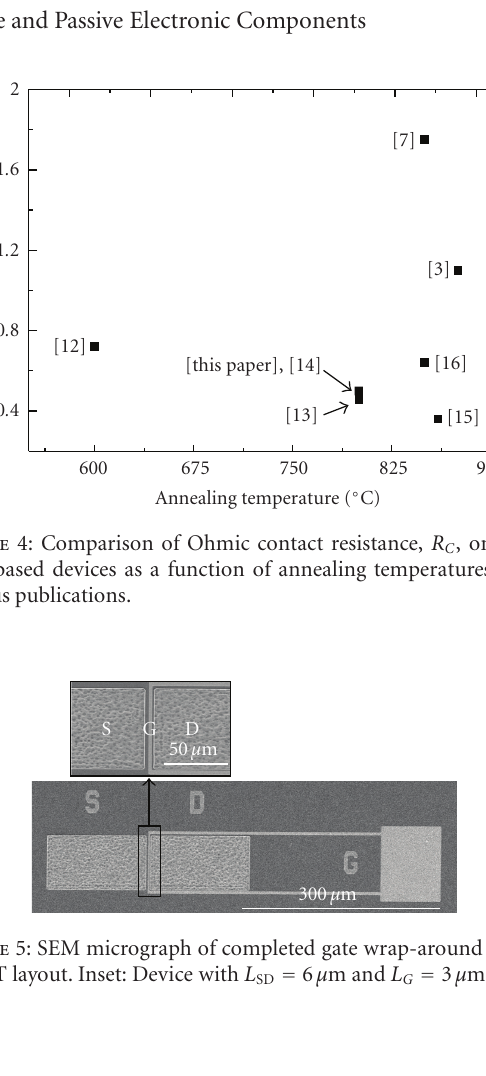
Figure 6: I DS - V DS characteristics of fabricated unprotected and unpassivated with 3 μ m × 100 μ m device (a) AlGaN/GaN HEMT and (b) AlN/GaN